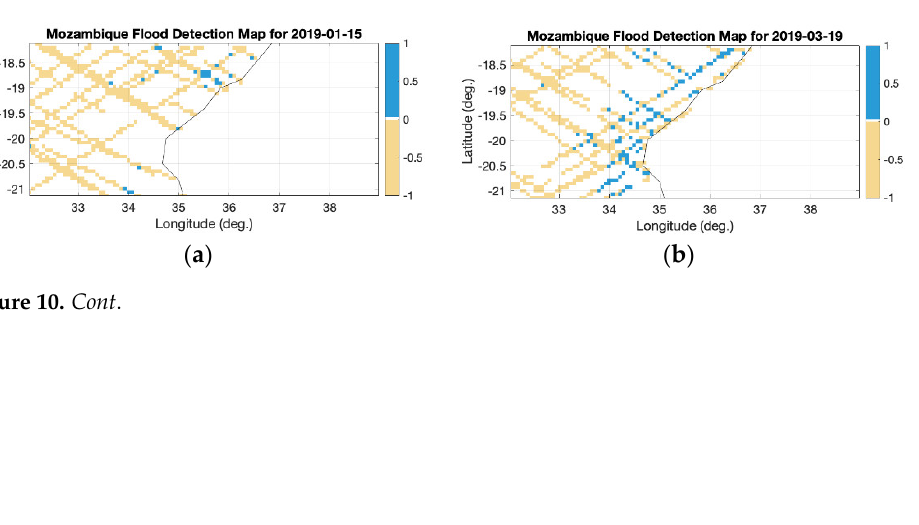
Figure 9. Flooding maps obtained from CYGNSS data using SNR observable for ( a ) 2019-01-15, ( b ) 2019-03-19, ( c ) 2019-03-25 and ( d ) 2019-05-15.